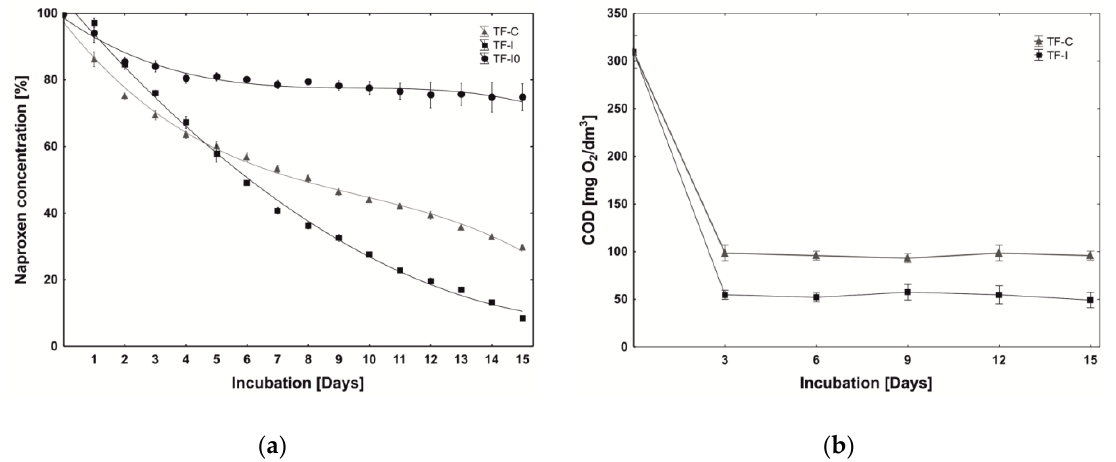
Figure 1. The trickling filters (TF) performance: ( a ) naproxen (1 mg/L) biodegradation: TF - C ( Δ ), TF- I (□) and TF - I0 (o); ( b ) removal of the COD in TF - C (Δ), TF - I (□).Data are presented as the mean ± the standard deviation of three